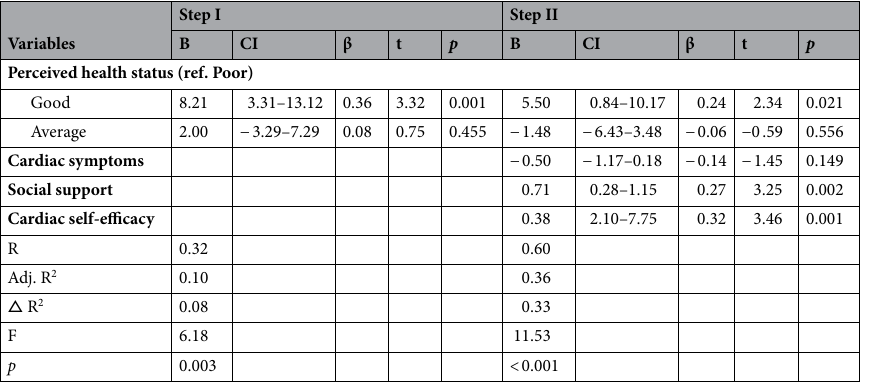
Table 6. Hierarchical regression of mental health-related Quality of life (N = 110). CI confidence interval.